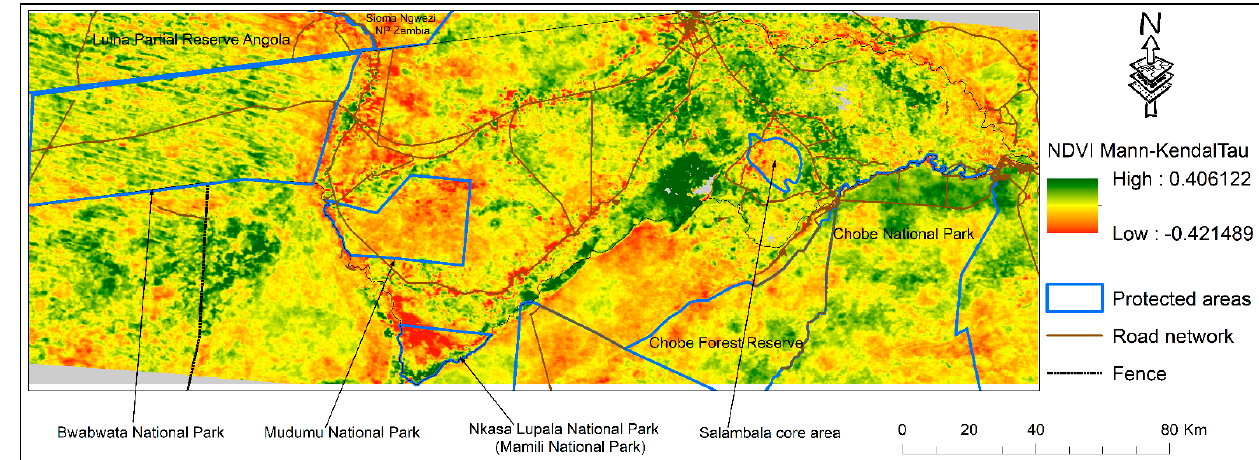
Figure 5. Additional